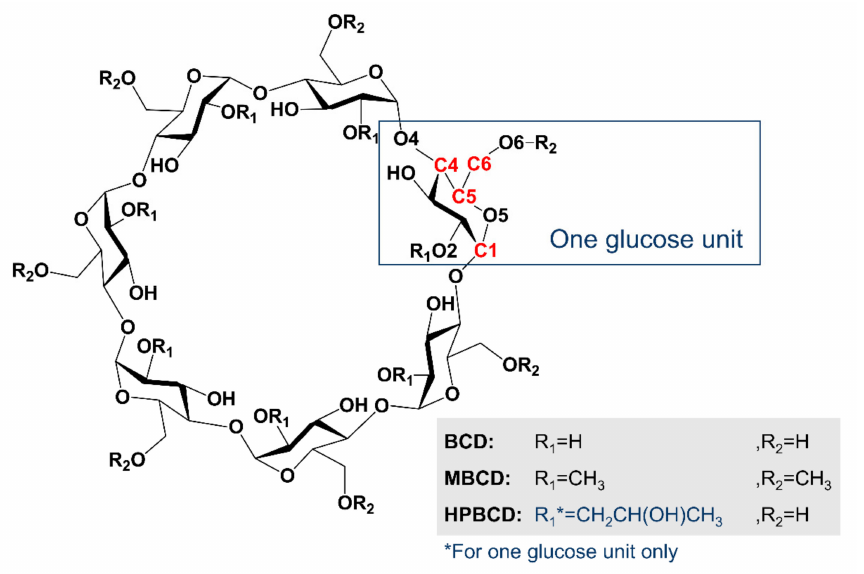
Figure 2. Schematic representation of glucose unit and atomic numbering of BCD, MBCD, and HP- BCD. (C1, C4, C5, and C6 refer to the numeric indexes of carbon atom position in each glucose